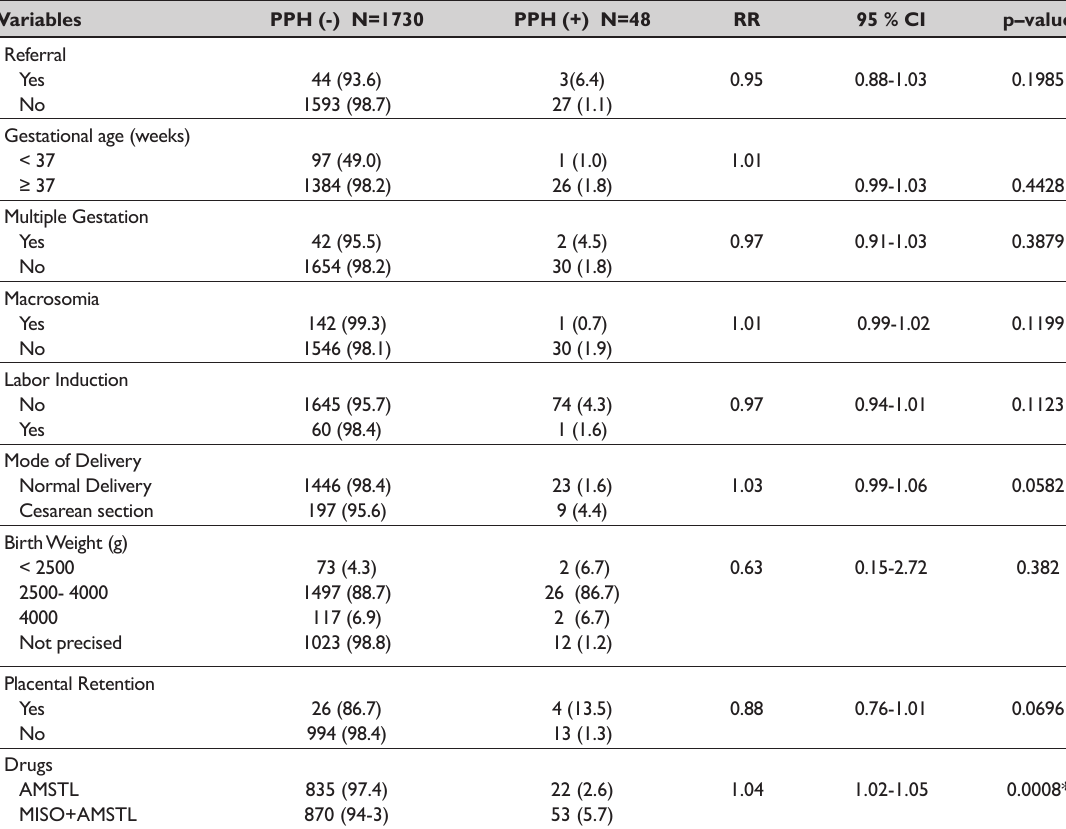
Table 3: Factors associated with postpartum hemorrhage